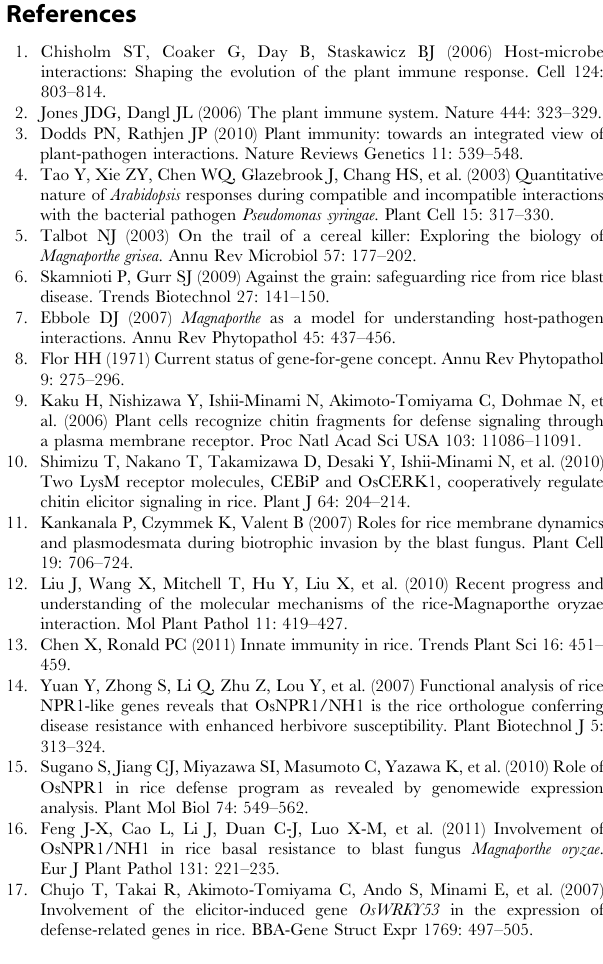
Table S6 List of differentially regulated genes involved in jasmonic acid biosynthesis pathway. Table S7 List of differentially regulated transcription factor genes. Table S8 The result of rice blast disease assay on pUbi:OsWRKY47 transgenic plants. Table S9 Pearson’s correlation efficiencies between biological